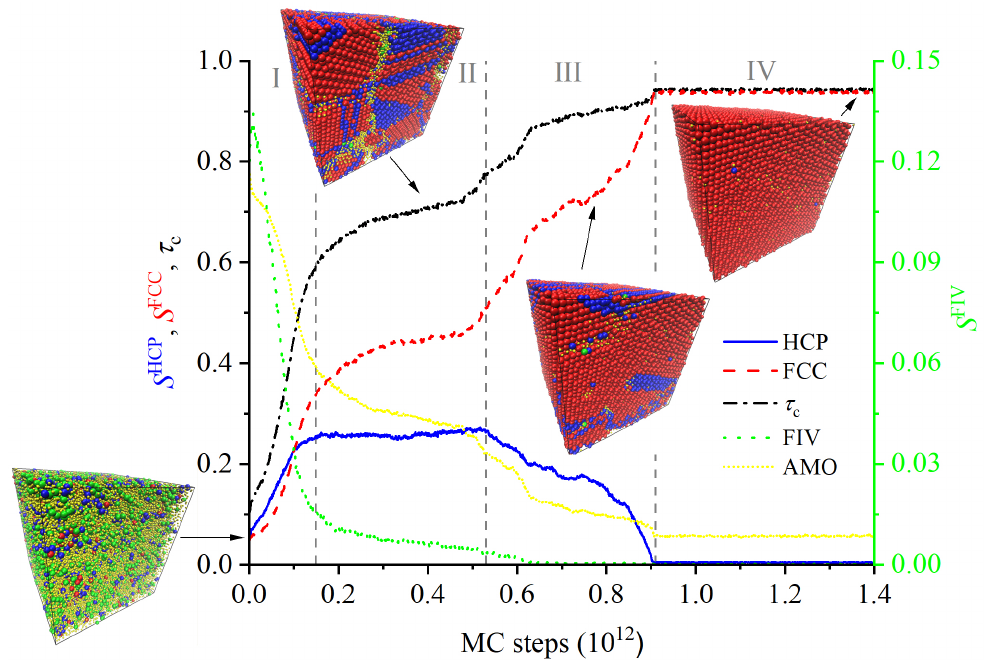
Figure 1. Evolution of the number fractions, S X , X ∈ [ HCP, FCC, FIV, AMO ] of sites of each type along the MC calculation. Fivefold-order parameter is shown on the right y -axis. Roman numerals and dashed vertical lines denote the four distinct regions in the evolution of the morphology (see main text). Also shown are perspective visualizations of representative frames in the four regimes. Spherical monomers are colored following the same convention as the curves according to their point group symmetry/crystal type: HCP: blue, FCC: red , FIV: green, and AMO: yellow. The corresponding curves are represented by solid (HCP), dashed (FCC), dotted (FIV), dashed-dotted ( τ c ), and short- dotted (AMO) styles. The correspondences of the color scheme and line style to the HCP/FCC/FIV structures of this figure are valid for the rest of the manuscript. For the system snapshots, the corresponding order parameters are: Frame 1 (Region I): S HCP = 0.0548, S FCC = 0.0406, S FIV = 0.108; Frame 4000 (Region II): S HCP = 0.259, S FCC = 0.452, S FIV = 0.006; Frame 8000 (Region III): S HCP = 0.149, S FCC = 0.751, S FIV = 5 × 10 − 4 ; Frame 14,000 (Region IV): S HCP = 0.005, S FCC = 0.940, S FIV = 9 × 10 − 5